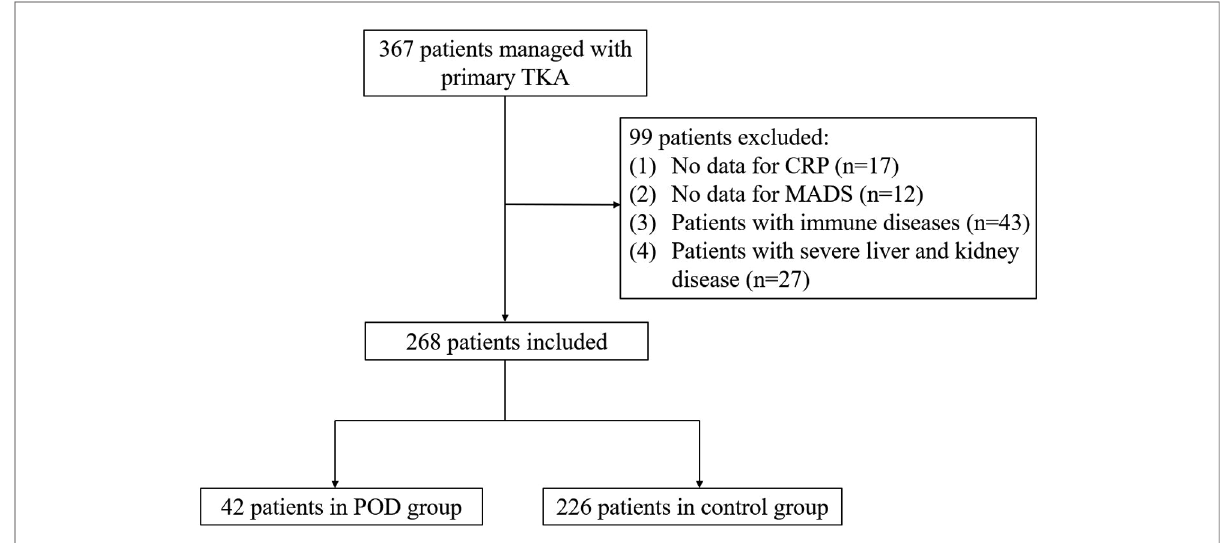
FIGURE 1 Flowchart of included and excluded cases. Aberrative: TKA, total knee arthroplasty; POD, postoperative delirium; MADS, memorial delirium assessment scale; CRP, C-reactive